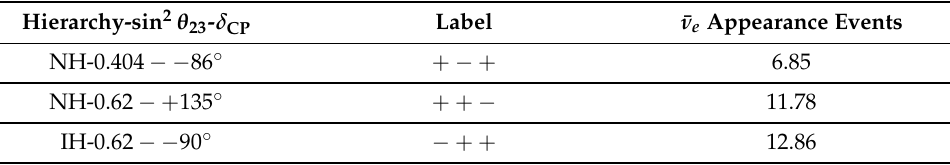
Table 6. Expected ¯ ν e appearance events of NO ν A for 6.05 × 10 20 POT, and for the three solutions in Ref.